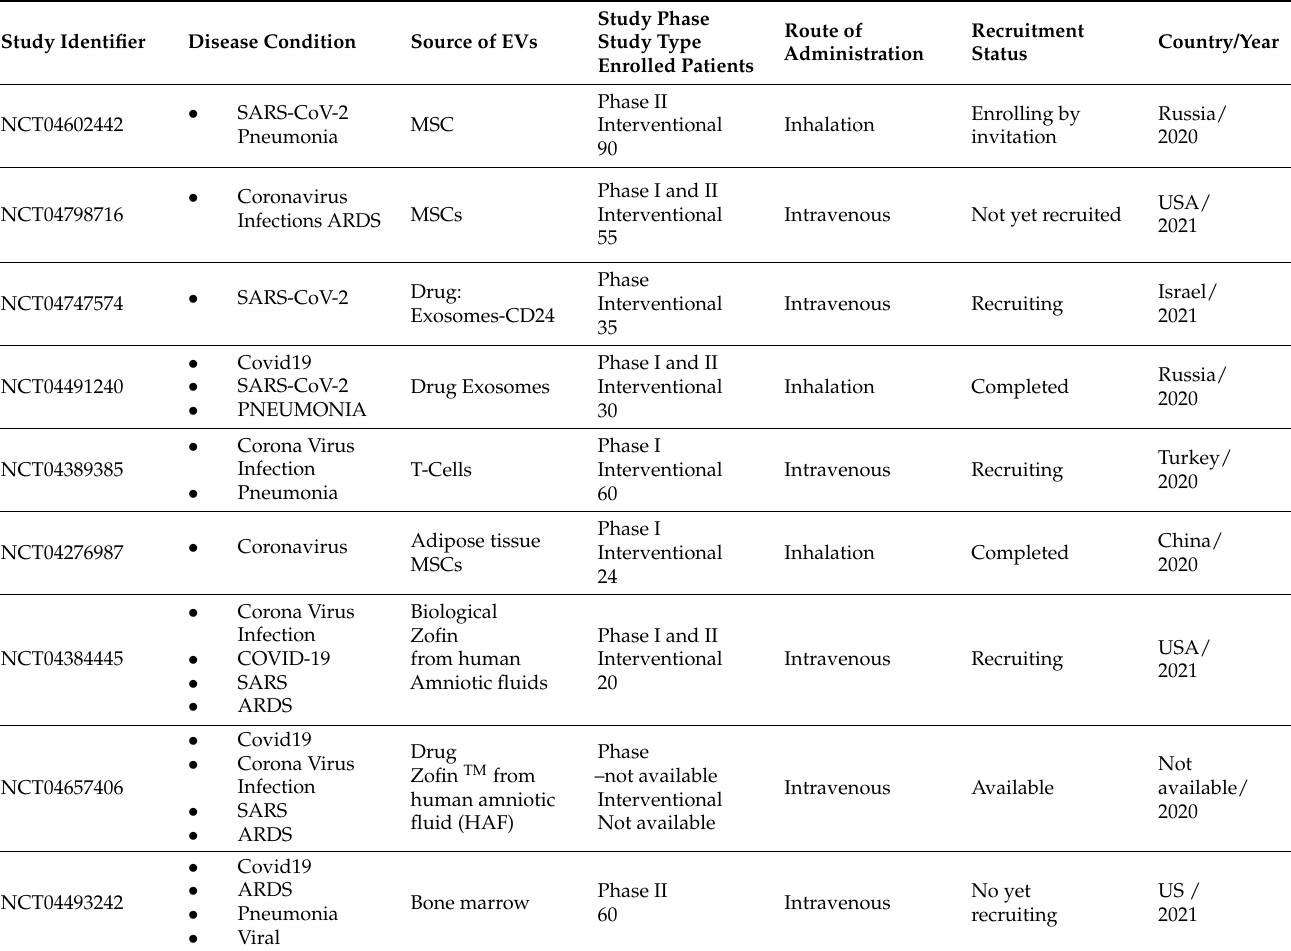
Table 1. Clinical trials registered on ClinicalTrials.gov until May 16, 2021, utilizing extracellular vesicles and/or exosomes for the treatment of